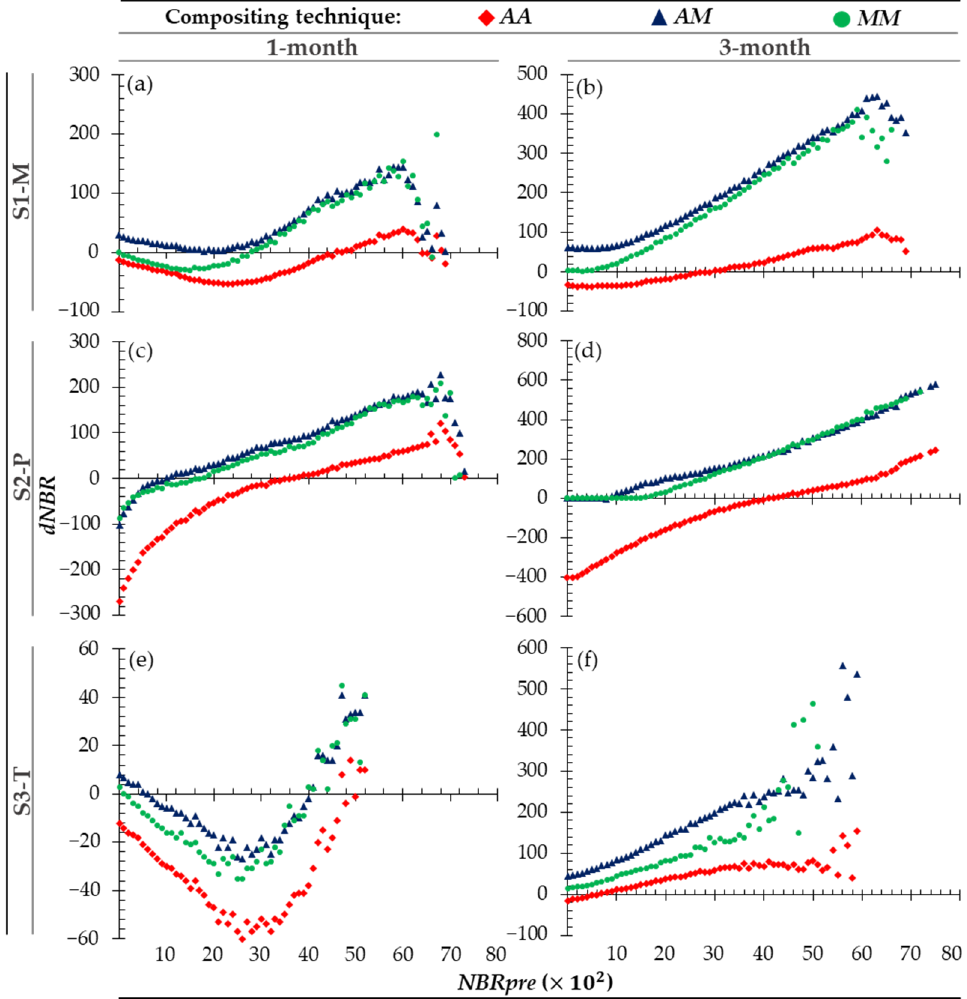
Figure 5. Average dNBR by NBRpre in the unburned buffer for sites 1 ( a , b ), 2 ( c , d ), and 3 ( e , f ) for 1-month and 3-month composites ( a , c , e and b , d , f , respectively), where composite technique: AA = average in pre- and post-fire composites, AM = average (pre) and minimum (post), and MM = minimum (pre and post).